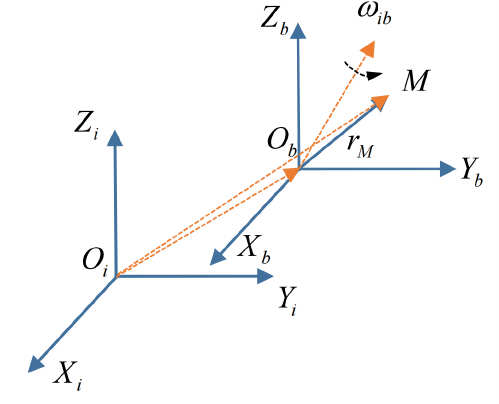
Figure 4. External lever arm effect sketch